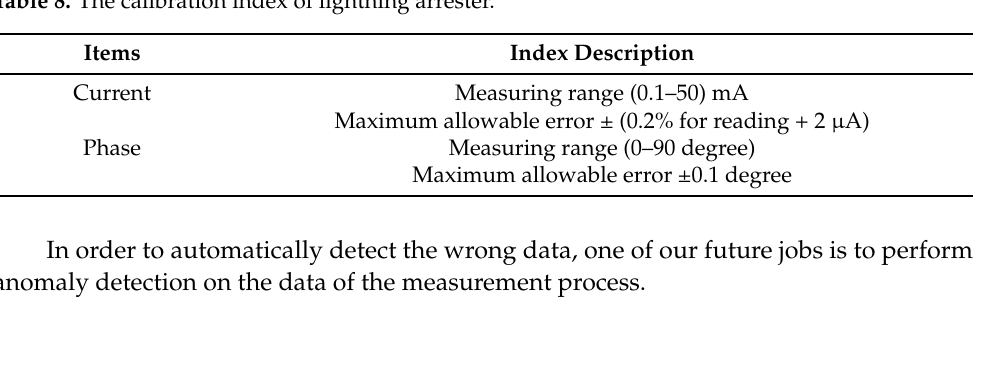
Table 8. The calibration index of lightning